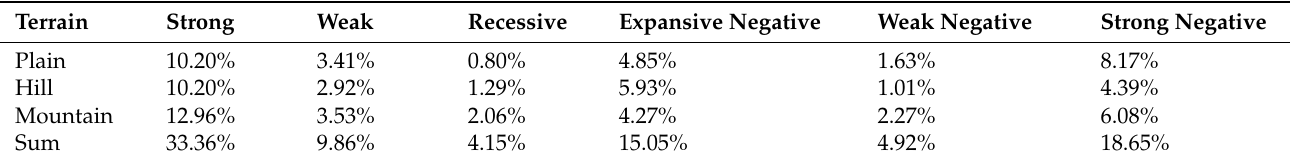
Table 4. Terrain and matching modes distribution in